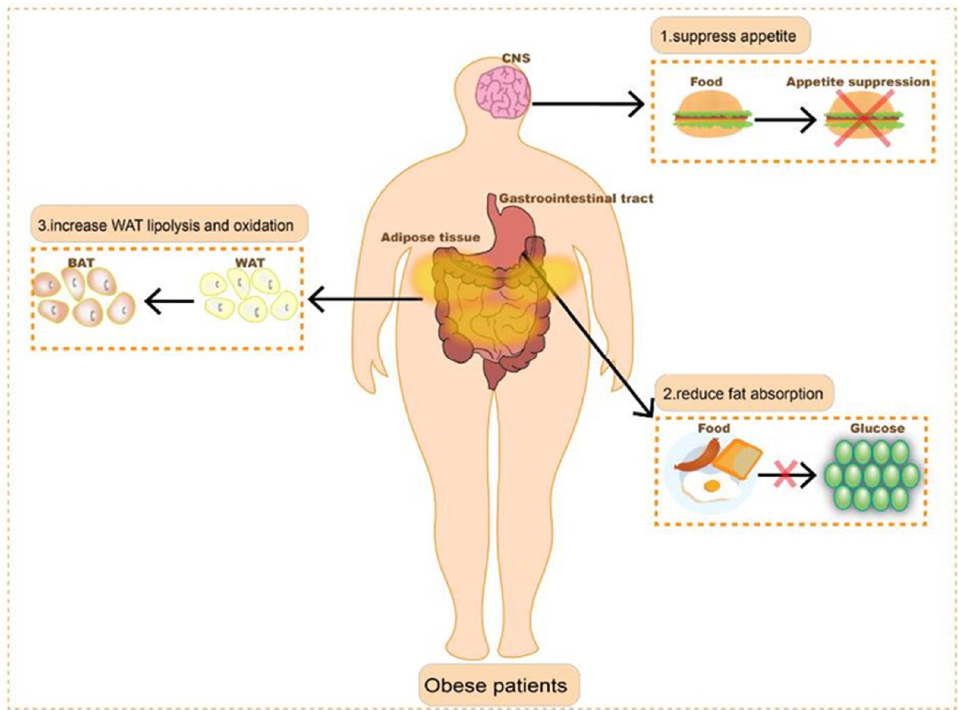
Figure 1. Main mechanisms of action of anti-obesity drugs. As the central pathways and pharmacological targets that regulate energy homeostasis are examined, including central pathways (e.g., the leptin–melanocortin axis and the opioid system), as well as specific signaling pathways of peripheral ligands acting on the central nervous system (e.g., the FGF21/FGFR1c/b-Klotho axis), several agents focusing on them are being investigated [47]. Leptin is a peptide hormone secreted mainly by WAT. It acts on the leptin receptor (LepRb) expressed in the hypothalamus to suppress appetite, increase energy expenditure, and inhibit adipogenesis. Protein tyrosine phosphatase 1B (PTP1B) is the key intracellular factor that negatively controls leptin signaling. A small- molecule inhibitor of PTP1B (an antisense drug called ISIS-PTP1BRX) has been shown to reduce body weight and glycated hemoglobin levels in subjects with T2D in clinical trials [48,49]. The central melanocortin system consists of neurons in the arcuate